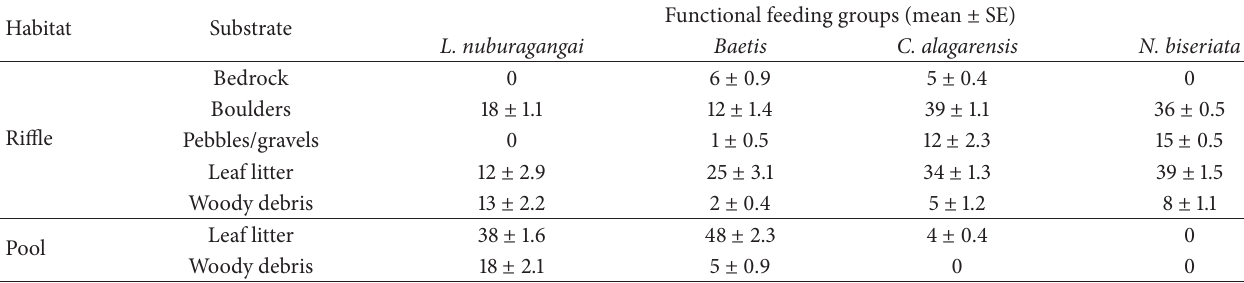
Table 2: Density (individuals/m 2 ) of functional feeding groups in the stream